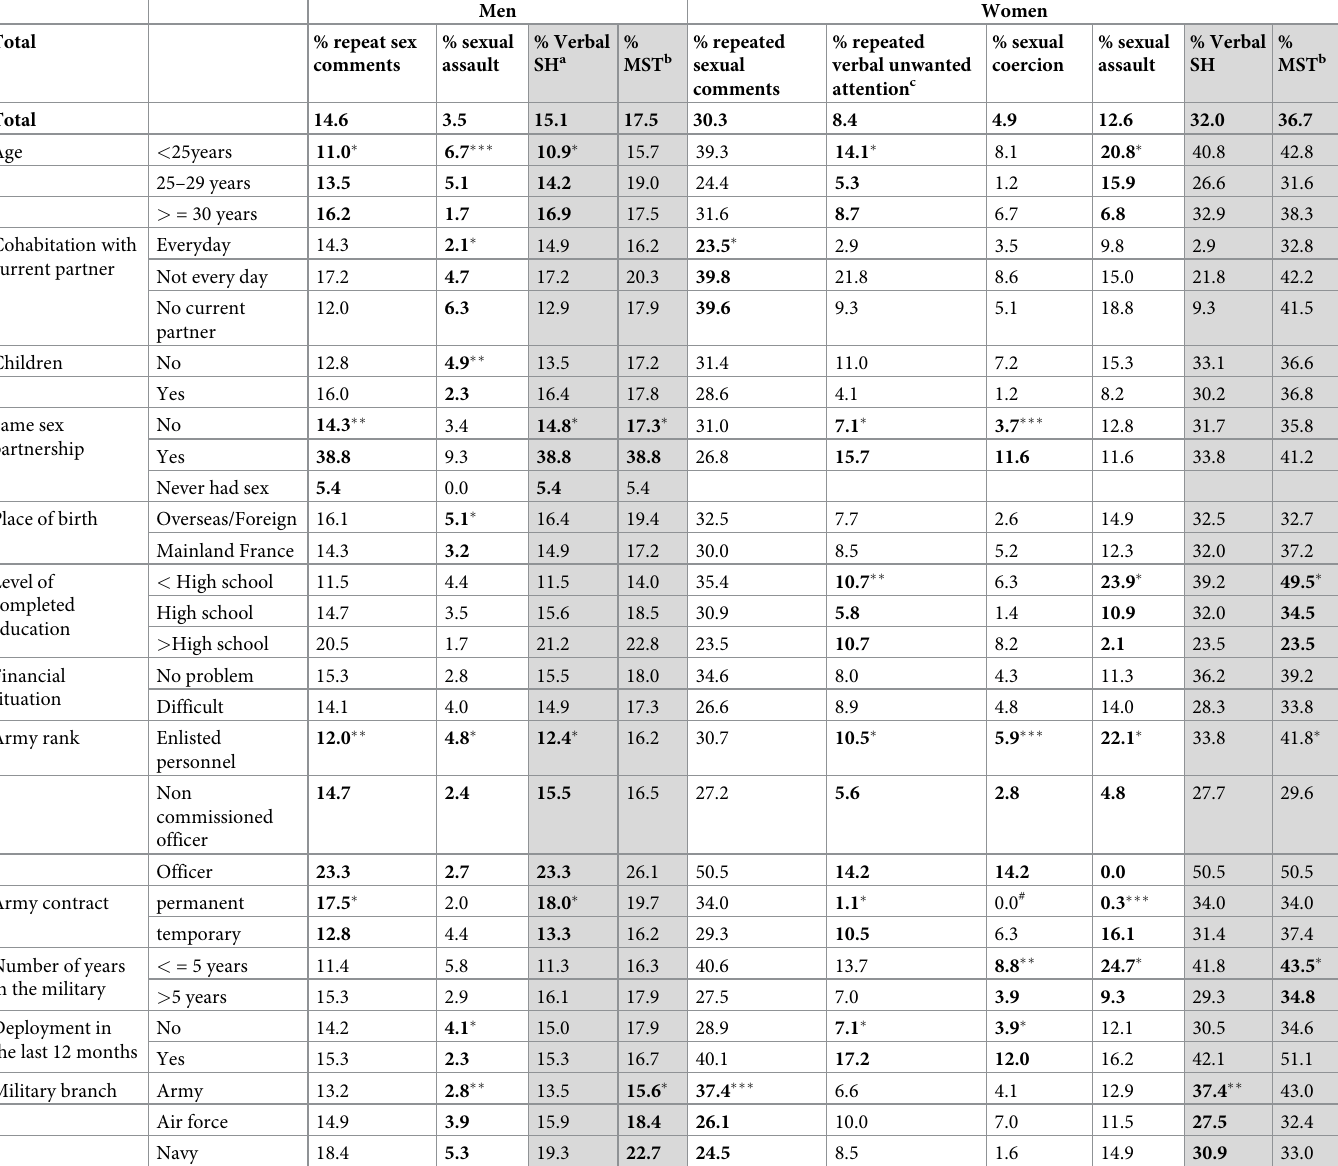
Table 3. Percentage of service members who report a repeated sexual comments , repeated unwanted verbal sexual attention , sexual coercion , or sexual assault in the military work environment in the last 12 months by gender and sociodemographic characteristics.